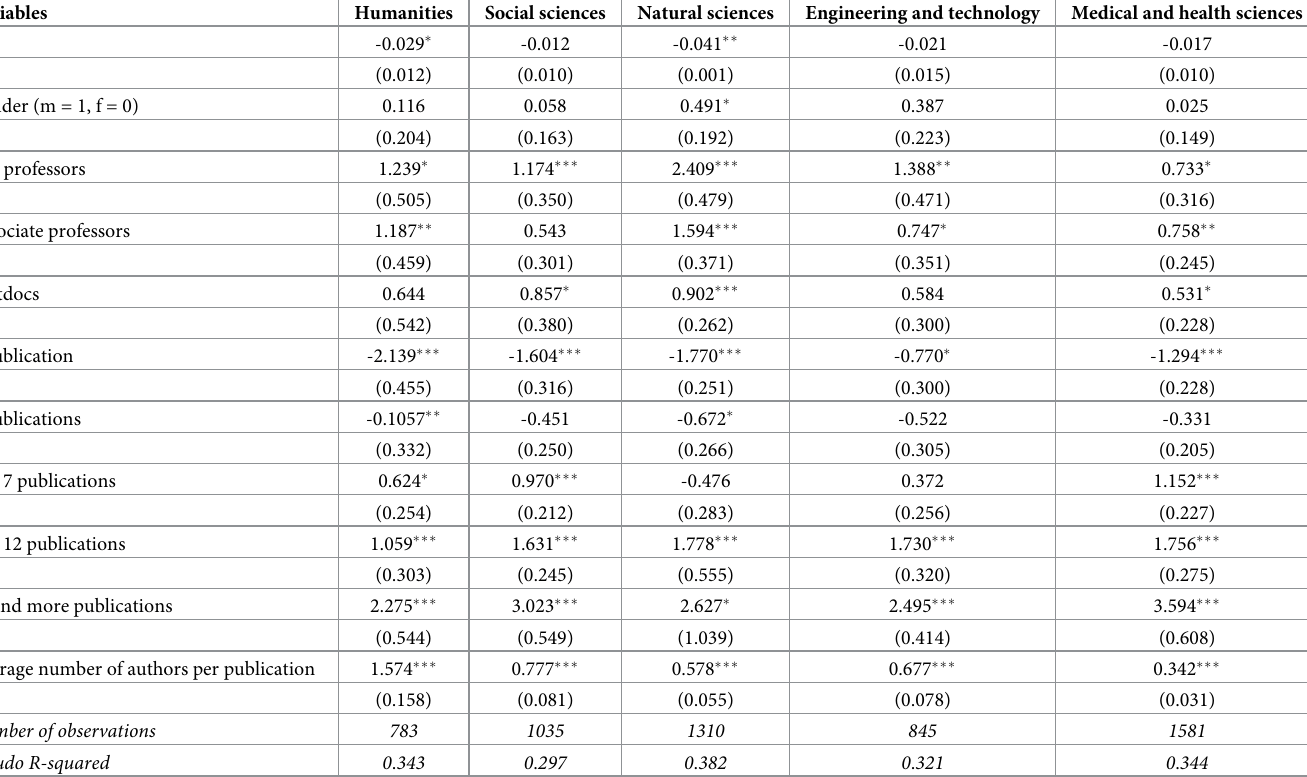
Table 5. Logistic regression analysis. Proportion of researchers involved in international collaboration (indicator A) and selected variables by major fields. Coefficients and std.